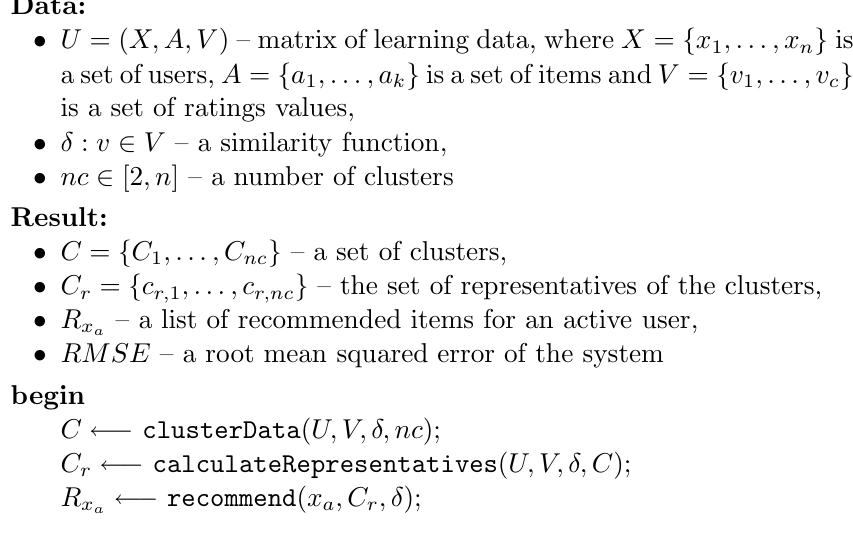
Algorithm 1 : A general algorithm of a recommender system used in